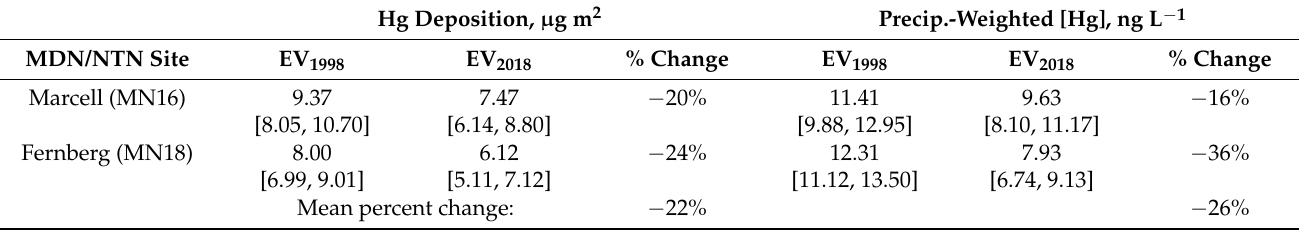
Table 3. Trend analysis results for wet mercury (Hg) deposition rate and precipitation-weighted mean concentrations for two National Atmospheric Deposition/Mercury Deposition Network sites in northern Minnesota. [Hg deposition µ g m − 2 , annual Hg deposition rate in micrograms per square meter; Precip.-weighted [Hg], ng L − 1 , annual precipitation-weighted mean Hg concentration in nanograms per liter; EV 1998 and EV 2018 are expected values for 1998 and 2018, respectively, from locally weighted regression of the variable of interest versus time in years. % change, percentage change in expected values from 1998–2018. Lower and upper 95 percent confidence limits shown in brackets.].